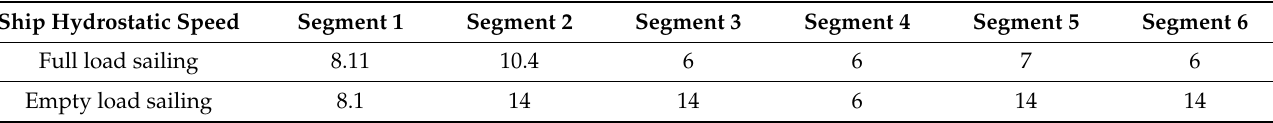
Table 6. Sailing plan of the ship in one whole navigation.